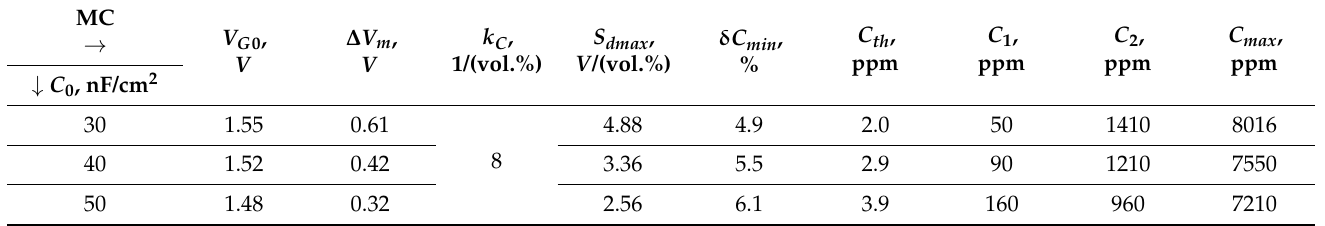
Figure 6. Dependence of δ C ( C ) for different C 0 : 1 → 30 nF/cm 2 ; 2 → 40 nF/cm 2 ; 3 → 50 nF/cm 2 . The values of C 1 and C 2 correspond to the square points on the curves. The color indicates the working area for the curve corresponding to the capacity of 50 nF/cm 2 . Table 4. Average values of metrological characteristics for different C 0 at δ C max being equal to 7%.